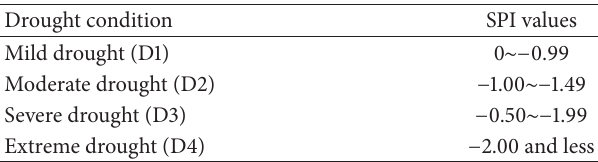
Table 3: Drought classification (drought intensity determined from [38]).